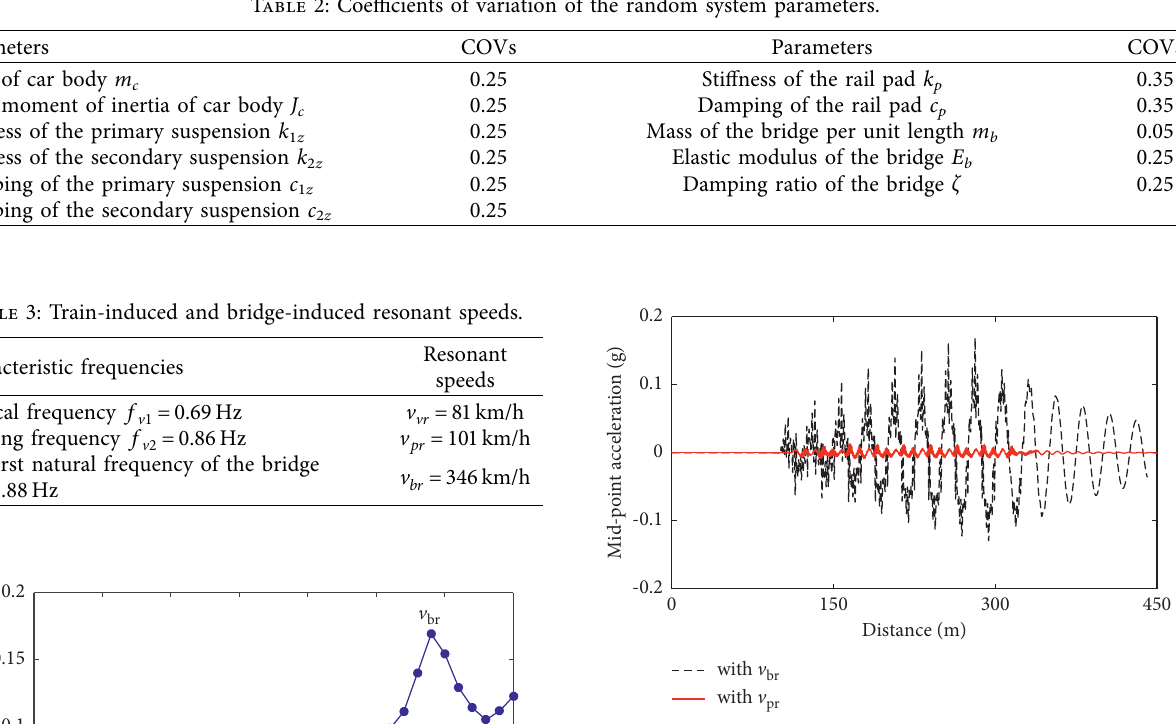
Figure 5: Time histories of bridge midpoint